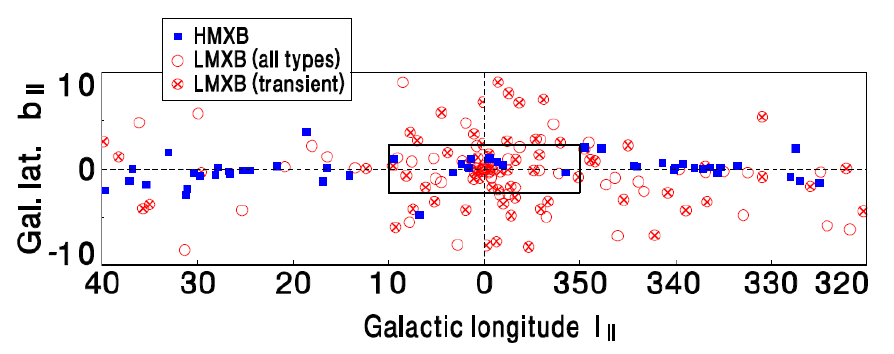
Figure 11. Field of center of galaxy (20 × 80 degrees). Positions of known Low-Mass X-ray Binaries (LMXBs) and High-Mass X-ray Binaries (HMXBs) are marked. Most dense accumulation is in galaxy center where LE telescope should be pointed Reprinted from